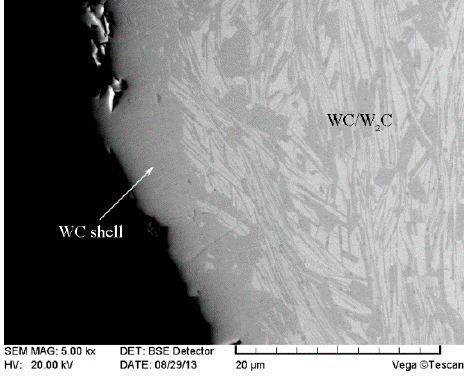
Figure 7. SEM image of the modified CTC P .